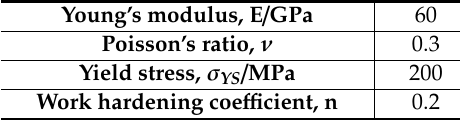
Figure 4. An example of FEM model (BCC lattice model) showing boundary conditions. Table 1. Material properties used for FEM analysis. The properties were determined based on the tensile properties of the AlSi10Mg alloy, which is fabricated by the laser powder bed fusion and subsequently heat-treated at 300 °C for 2 h [23].